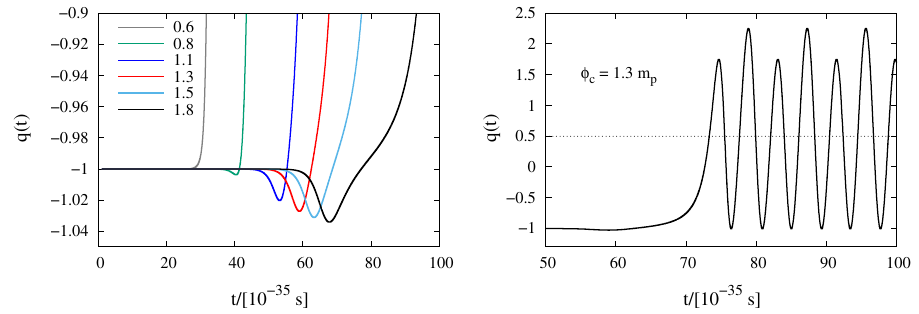
Fig. 3 Left panel: Evolution of the deceleration parameter q ( t ) as a function of time at the final stage of inflation in the vicinity of the bump in the Hubble function (in the legend we show the values of the param- eter φ c in units of Planck mass). Notice that before the maximum of the bump we have q ( t ) < − 1, i.e., a phantom like behavior. Right panel: Here we show the deceleration parameter for the first oscillations of the